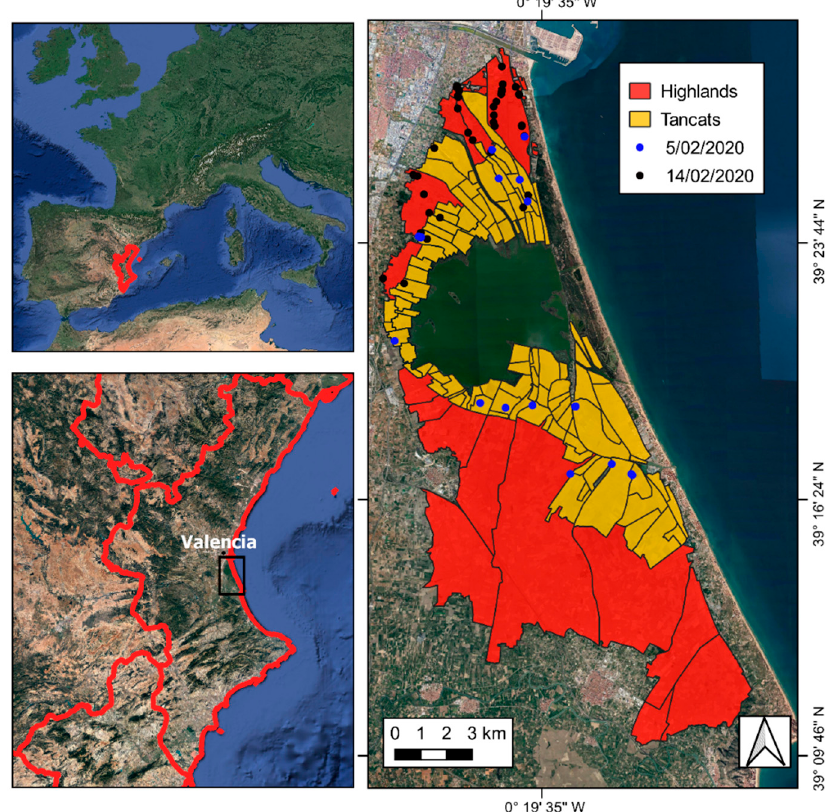
Figure 1. Overview of the Albufera wetland (© Google 2020) and outline of the rice fields with lower ( Tancats ) and higher elevation (highlands). The points represent the locations of field surveys performed on 5 February 2020 and 14 February 2020.